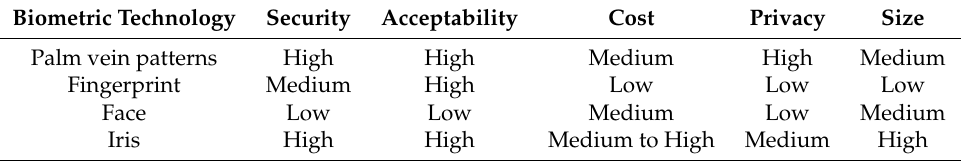
Table 1. Comparative analysis of characteristics of different types of biometric technologies, from [24]. Biometric